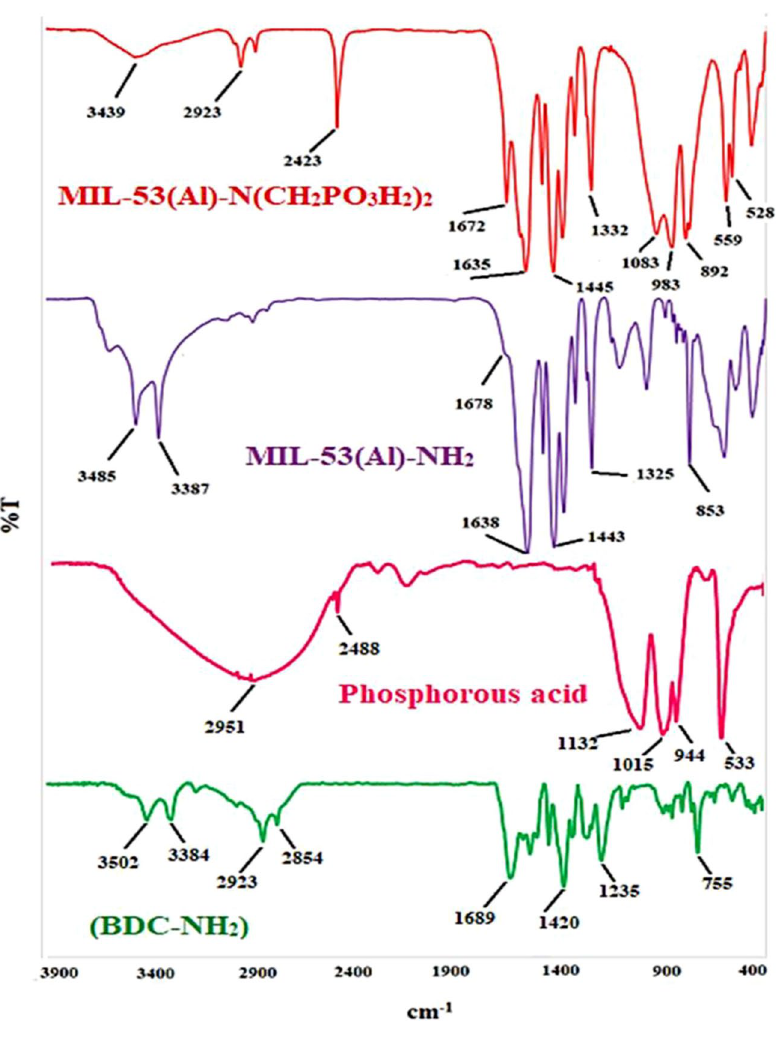
Figure 7. FT-IR analysis of 2-amino terephthalic acid, phosphorous acid, MIL-53(Al)-NH 2 and MIL-53(Al)- N(CH